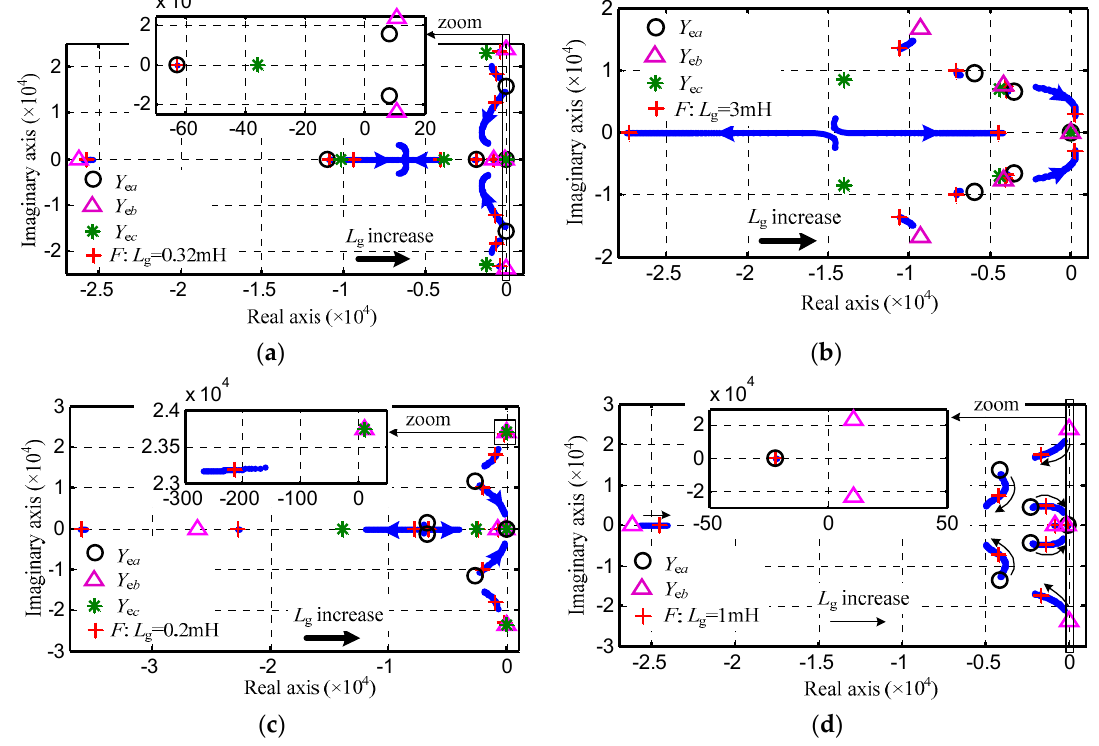
Figure 8. Pole maps of inverters and root locus of AN with grid impedance varying: ( a ) state-A: pole maps of the three inverters and root locus of AN with grid impedance varying; ( b ) state-B: pole maps of three inverters and root locus of AN with grid impedance varying; ( c ) state-C: pole maps of three inverters and root locus of AN with grid impedance varying; ( d ) state-D: pole maps of the two types of inverters and root locus of AN with grid impedance varying.